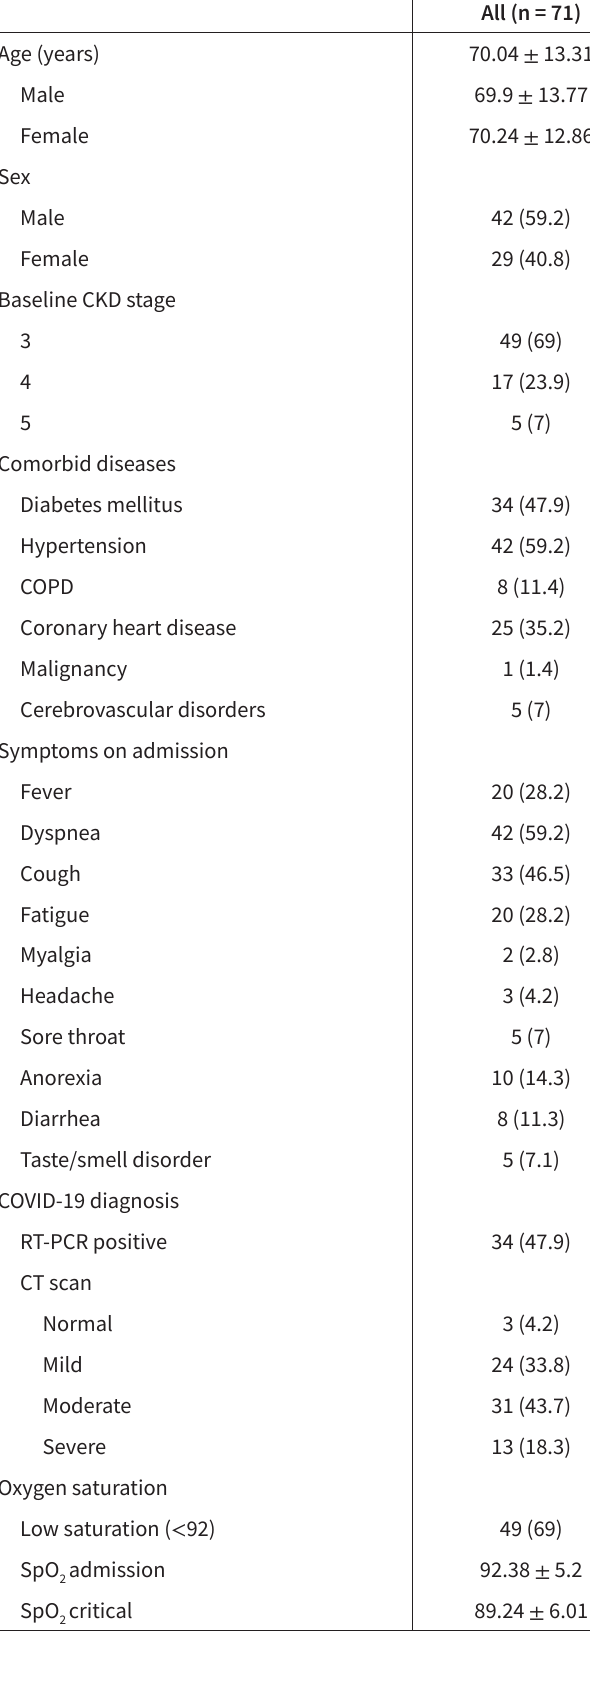
Table 1. Comparison of the Patient’ Characteristics Based on